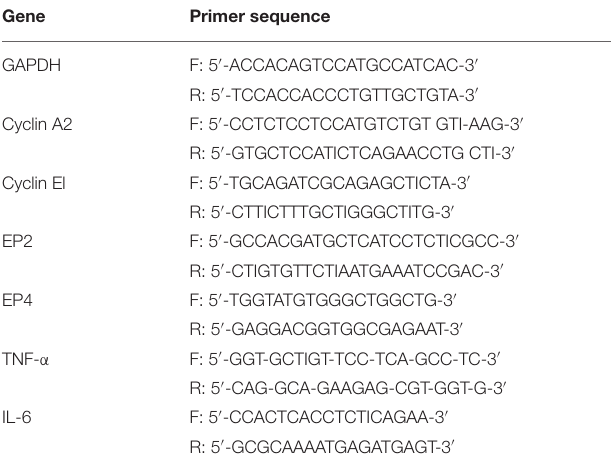
( Figure 2D ). The mean decreases in SKOV3 cells with higher concentrations of hWJSC-CM (25, 50, 75,100%) at 72 h and hWJSC-CL (15, 30, 50 µ g/ml) at 24, 48, and 72 h were statistically significant ( p < 0.05) compared to the